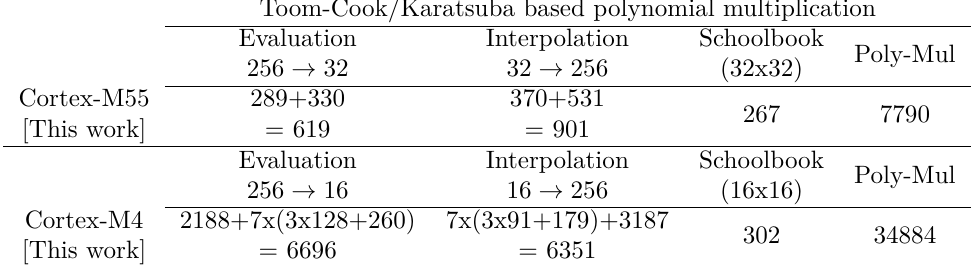
Table 4 Performance of polynomial multiplication based on Toom-Cook/Karatsuba. Sum- decompositions refer to shares of Toom-Cook/Karatsuba during